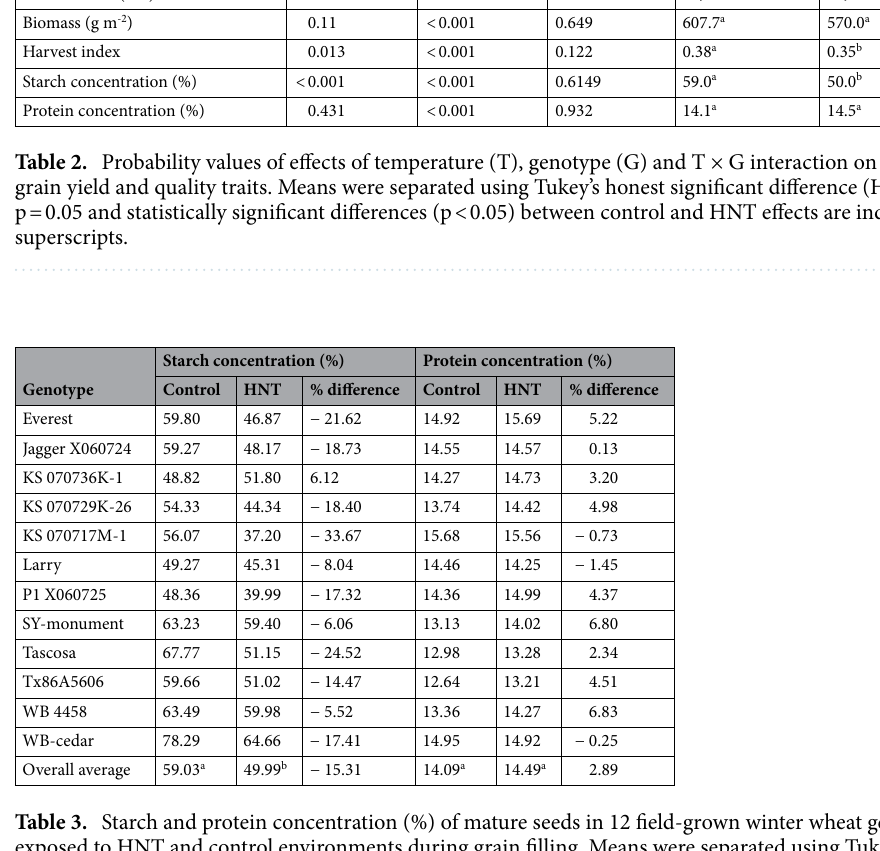
(Table 2). The two genotypes with the largest reduction were P1 X060725 and Tascosa. On average, the 12 genotypes recorded a 5.4% or 1.4% per °C reduction in the biomass. Tx86A5606 has the largest increase in aboveground biomass at 17%, which is due to higher variation in measurements ranging from a 3.5% reduction to a 50% increase in biomass (Supplementary Fig. 7B). HNT stress had a significant effect on HI with treatment and genotype but not with their interaction (Table 2; Supplementary Fig. 7C). While eight genotypes recorded a reduction in HI, the only genotype that was significantly reduced was P1 X060725 (Supplementary Fig. 7C). Starch and protein concentration. The HNT stress effect on grain starch concentration was statistically signifi- cant at the treatment and the genotype level but not their interaction (Table 2). Eleven of the 12 genotypes had reduced starch concentration, with just KS 070736K-1 not affected negatively (Table 3). The largest reduction